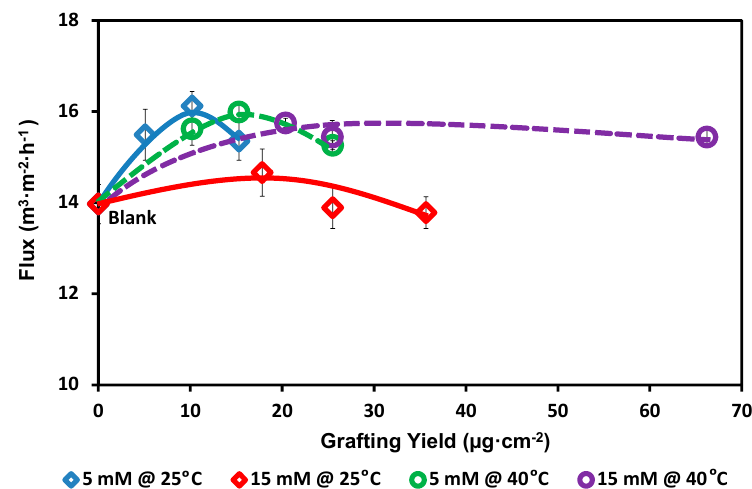
Figure 4. The effect of the grafting yield on the pure water flux of the membrane. Common reaction condition is pH 5.5 (0.1 M sodium acetate buffer), and 0.5 U·mL − 1 enzyme (laccase). Reaction at 25 °C using 5 mM 2-AP (blue diamond) and 15 mM 2-AP (red diamond), and reaction at 40 °C using 5 mM 2-AP (green circle) and 15 mM 2-AP (purple circle). Resection times 30, 60, and 120 min were tested and the grafting yield was increased with increasing the reaction time. The solid and dashed lines are guides for general trend for the studied conditions.